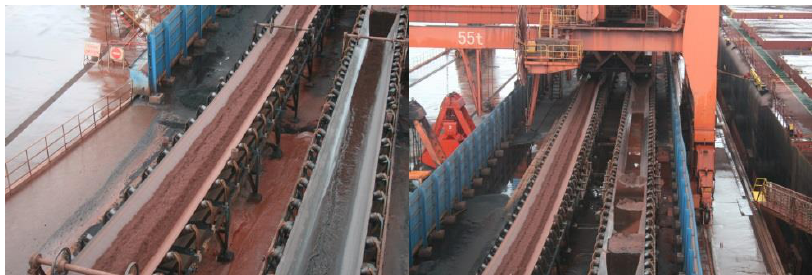
Figure 1. The phenomena of unevenly distributed or intermittent bulk materials on the conveyor belt.